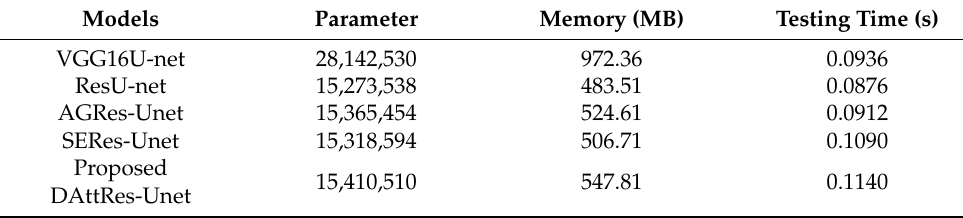
Table 4. Parameters, memory, and testing time of the comparative